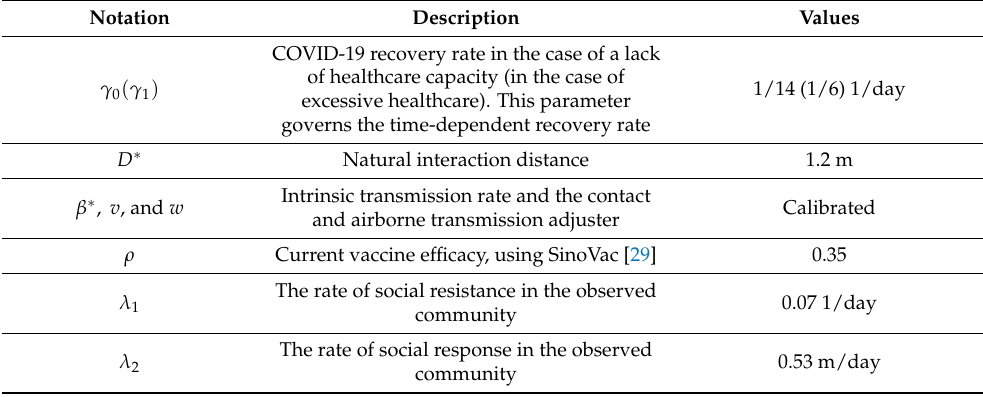
Table 4. List of parameters used in evaluating the numerical simulation of System (1) and